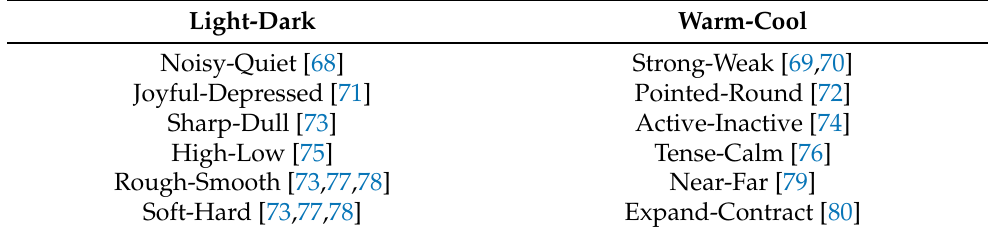
Table 7. Semantic adjectives for scent and color dimensions (light-dark and warm-cool) mediation.